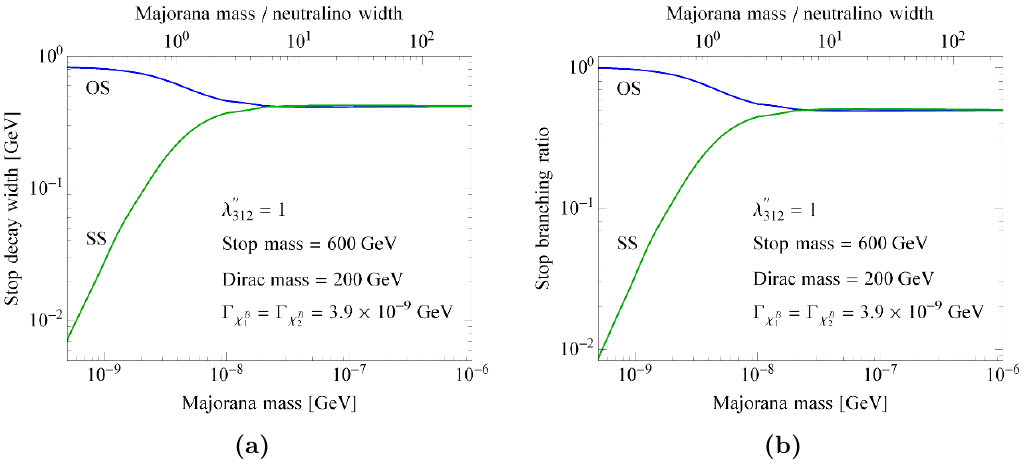
Figure 8. Partial decay widths (a) and branching ratios (b) for 600 GeV stops decaying into opposite sign (OS) and same sign (SS) tops through approximately 200 GeV bino neutralinos with (cid:21) 00 = 312